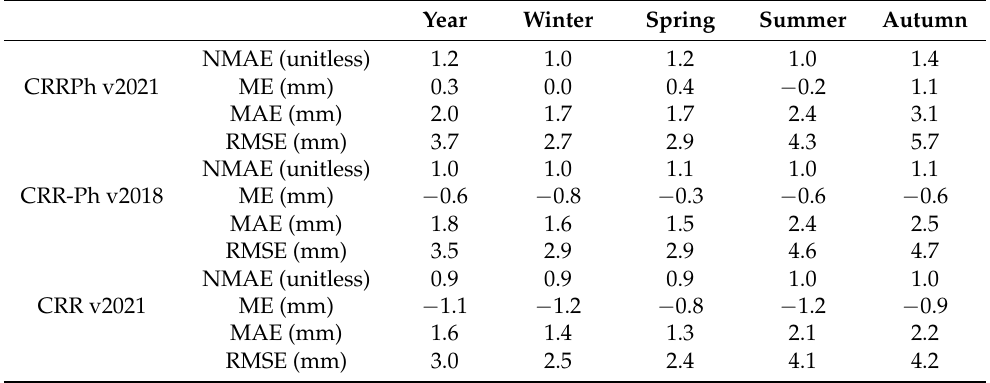
Table 5. Twenty-four-hour error statistics for CRRPh v2021, CRR-Ph v2018, and CRR